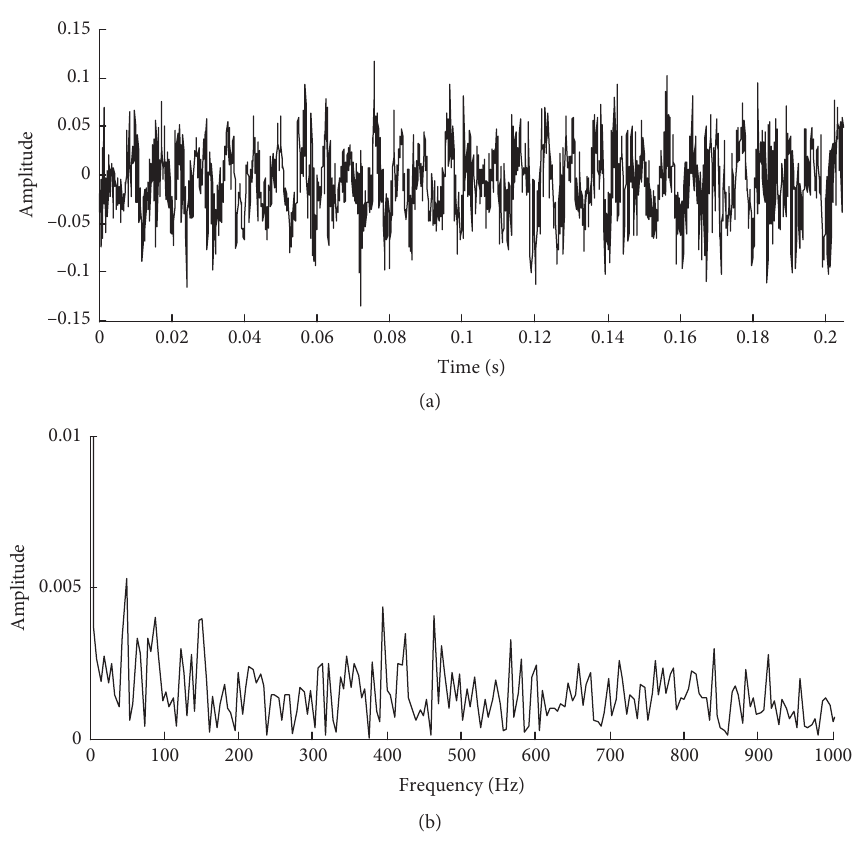
Figure 19: Fault signal and envelope spectrum of outer race